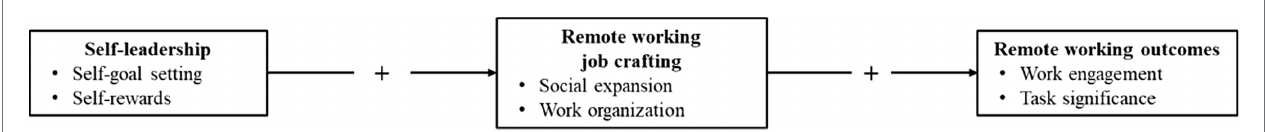
FIGURE 1 | Model of remote working proactivity processes and